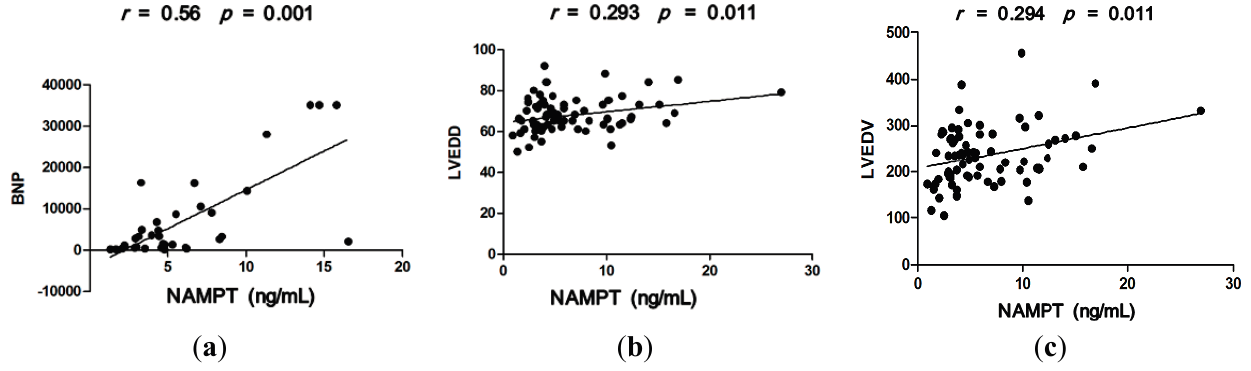
Figure 4. ( a ) Serum NAMPT levels are positively correlated with BNP of DCM patients ( r = 0.56, p = 0.001); ( b ) Serum NAMPT levels are positively correlated with LVEDD of DCM patients ( r = 0.293, p = 0.011); ( c ) Serum NAMPT levels are positively correlated with LVEDV of DCM patients ( r = 0.294, p =